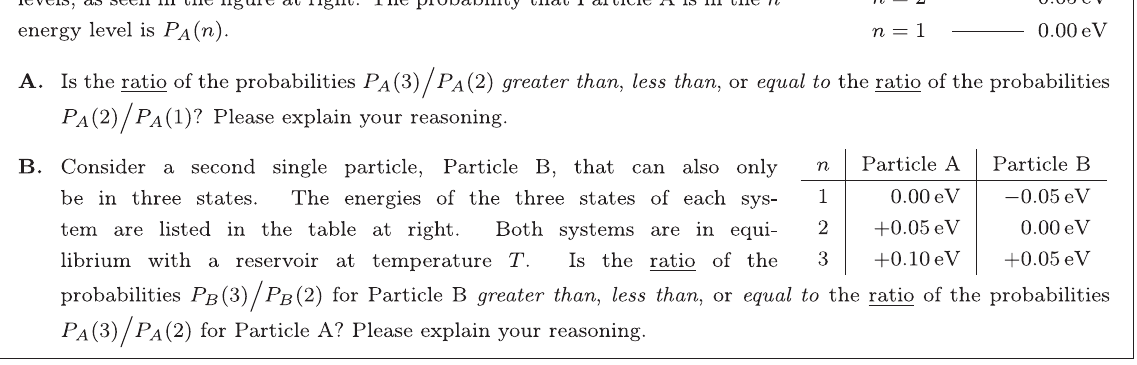
FIG. 2. Probability ratios question (PRQ) given as an ungraded survey before tutorial